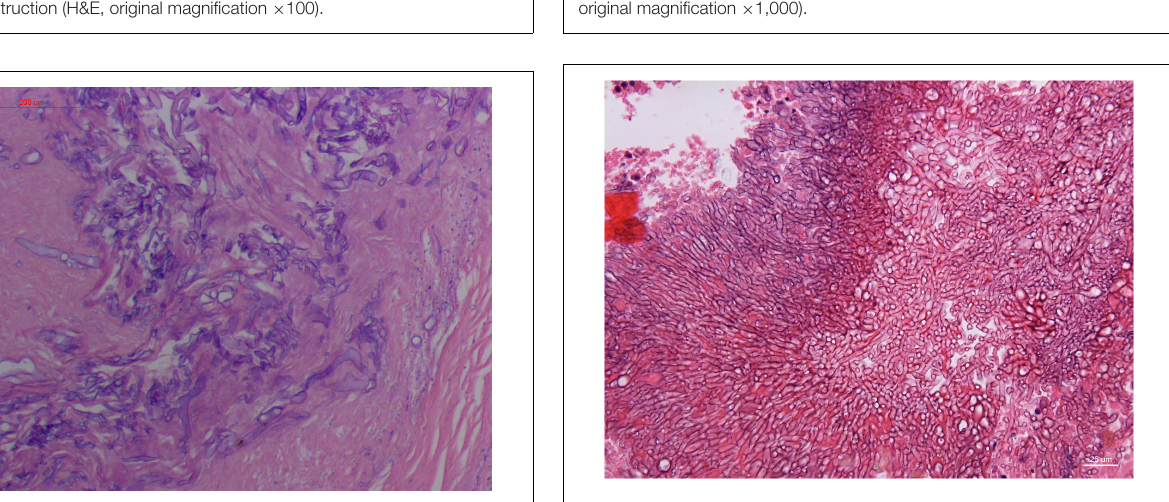
FIGURE 2 | “Extranodal natural killer/T-cell lymphoma, nasal type/rhino-orbital-cerebral mycosis.” Broad thin-walled hyphae of Rhizopus arrhizus (H&E, original magnification × 400).